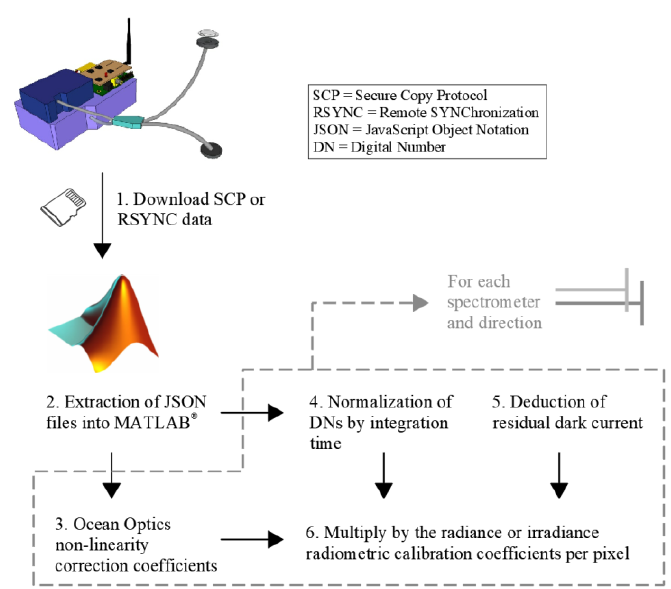
Figure 1. Piccolo-Doppio data processing workflow to obtain radiance. In step 2, an analogue data processing flow was developed in Python3.